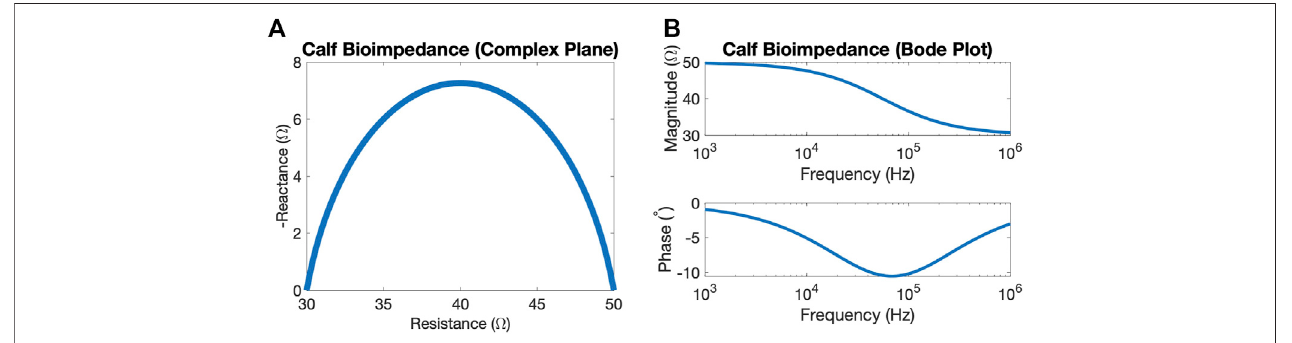
FIGURE1| Twoviewsofanexamplecalfbioimpedancewaveformwith R 0 (cid:1) 50 Ω , R ∞ (cid:1) 30 Ω , τ (cid:1)